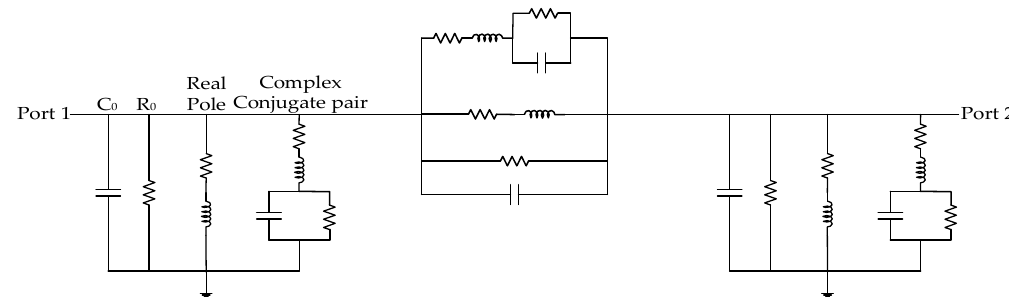
Figure 3. General representation of a 1st order, two port pole-residue equivalent circuit.